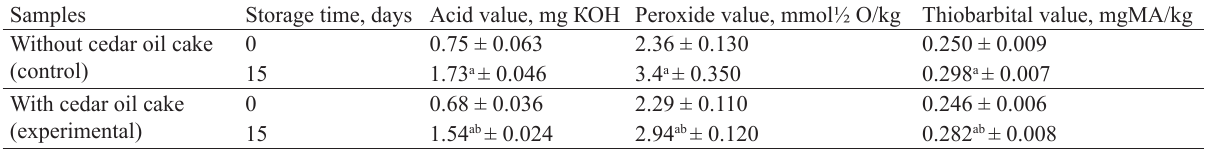
Table 7 Indicators of oxidative damage in semi-smoked sausages Samples Without cedar oil cake With cedar oil